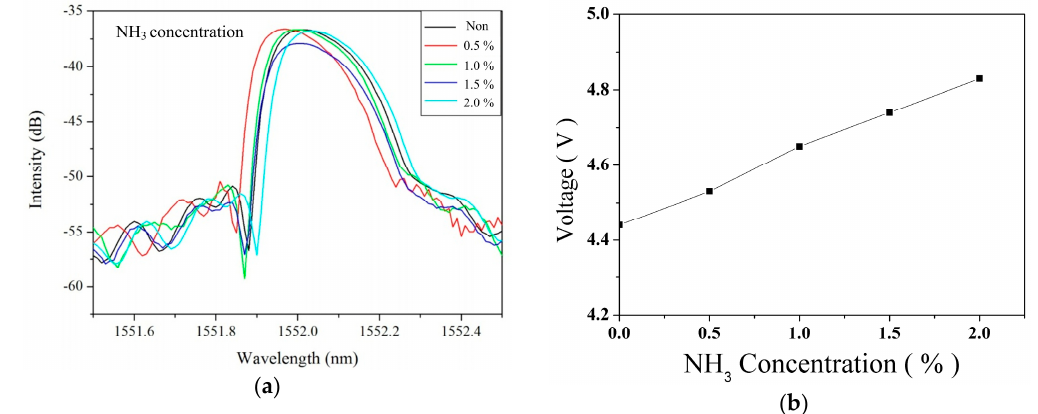
Figure 8. ( a ) The red shifts of the FBG sensing spectra induced by various NH 3 concentrations; and ( b ) the sensed relationship between NH 3 concentration and voltage response.